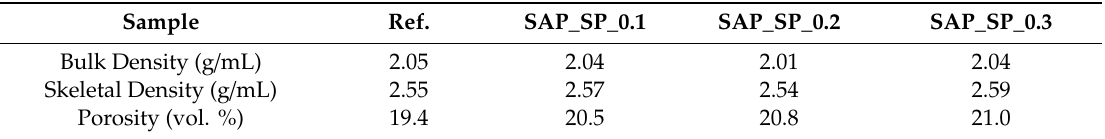
Table 3. Bulk density, skeletal density, and porosity of mortar samples as measured by a mercury intrusion porosimetry (MIP) test.